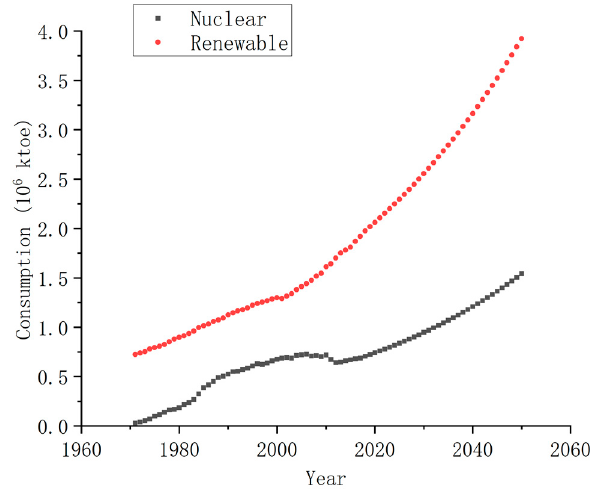
Figure 5. The supply of nuclear and renewable energy in the influenced model.